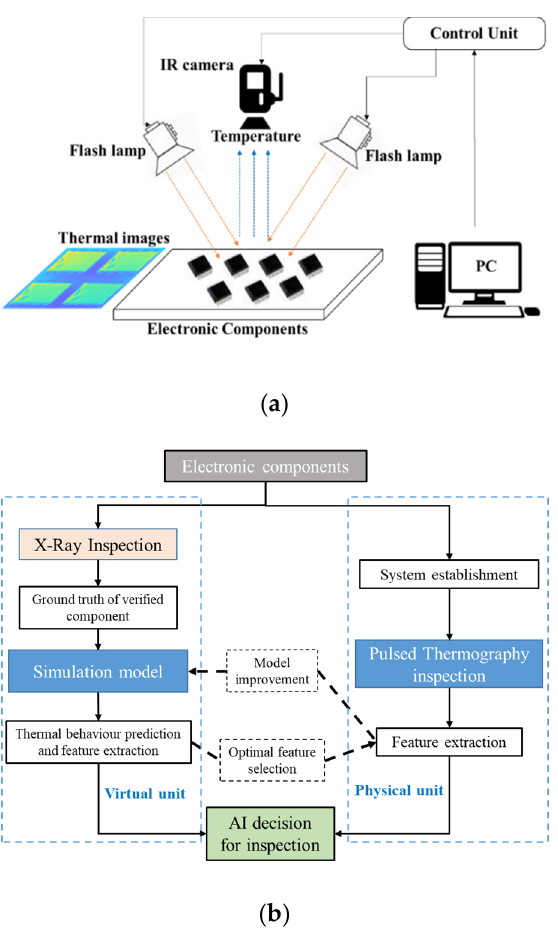
Figure 3. The methodology framework. ( a ) The principal of pulsed thermography; ( b ) The proposed dual-path strategy for electronic components inspection.